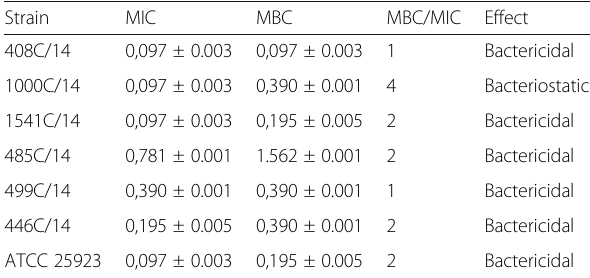
Table 2 Antibacterial activity of ethyl acetate extract of Tieghemella heckelii on Methicillin- resistant and reference strains of Staphylococcus aureus